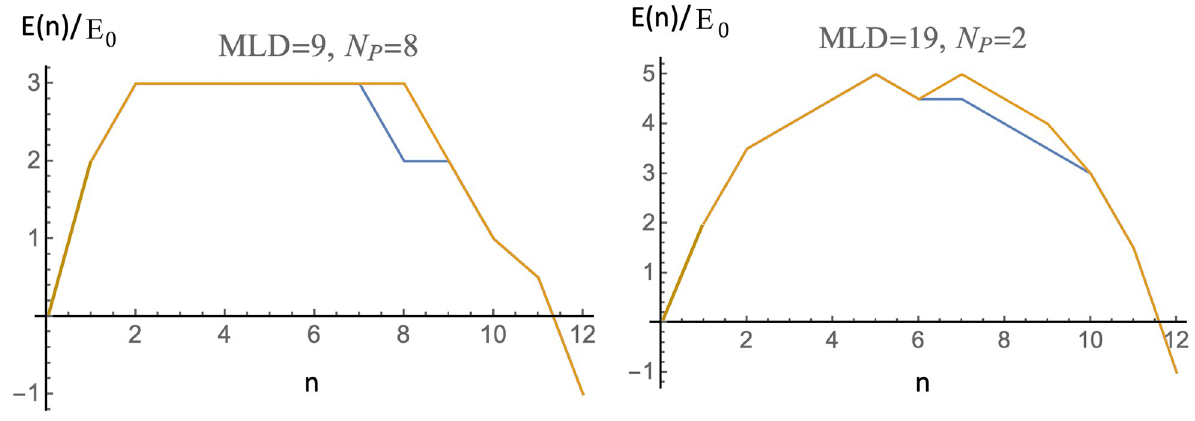
Fig 4. Minimum-energy assembly energy profiles for N P = 8, MLD = 9 spanning trees (left) and for an N P = 2, MLD = 19 spanning tree (right). Energy parameters are � 1 = − 0.5 and μ 0 = − 4.0 (close to assembly equilibrium where μ 0 ’ − 4.083. Energies are expressed in units of the overall scale E 0 . The assembly energy profiles of spanning trees with the same N and MLD are nearly always the same. The pathways for the small number of P exceptions are shown in the